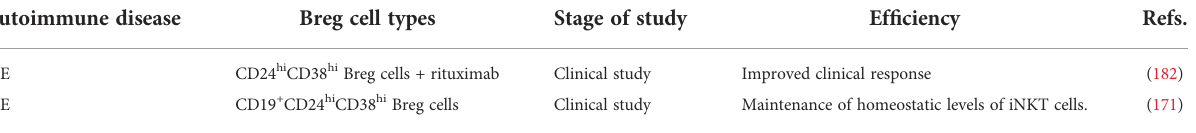
TABLE 2 Effect of Breg cells on autoimmune